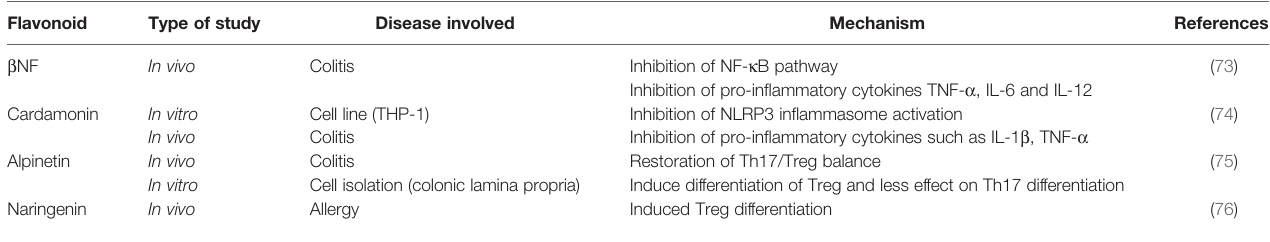
TABLE 1 | Effect of fl avonoids-induced immunomodulation via AhR.